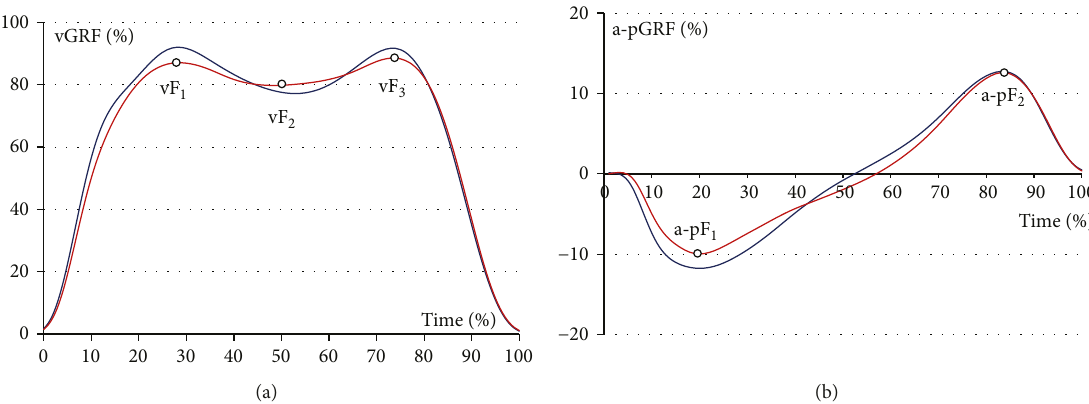
Figure 1: Vertical ground reaction force (vGRF) and anterio-posterior ground reaction force (a-pGRF) components for the amputated (red line) and intact (blue line) limbs with analyzed parameters for the amputated